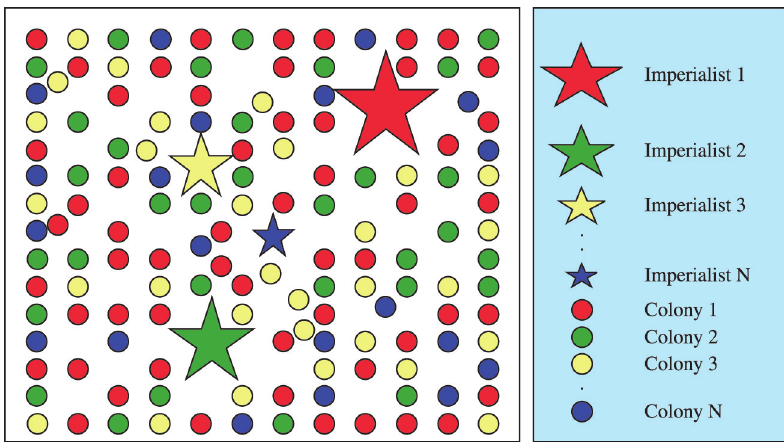
Figure 4. Generating the initial empires: The more colonies an imperialist possess, the bigger is its relevant ( ) mark.